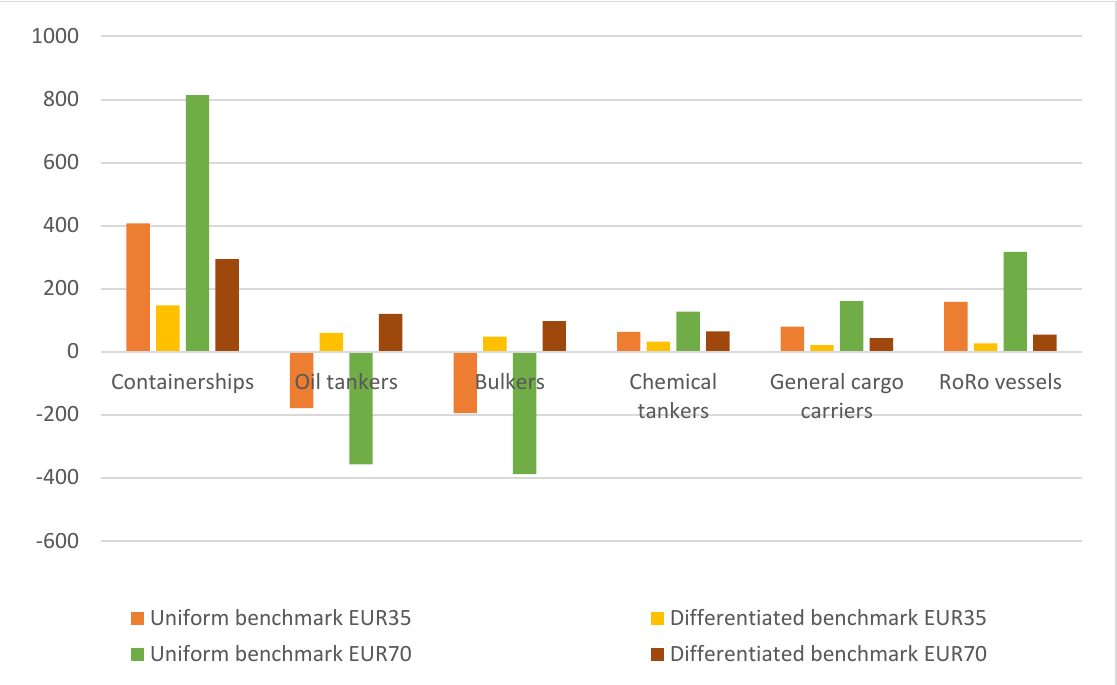
Figure 7. Cost increase per maritime segment assuming a uniform/differentiated benchmark and the inclusion of all inter- nal EU voyages and 50% of incoming and outgoing voyages from/to an EU port, expressed in MEUR. Source : Created by the authors.